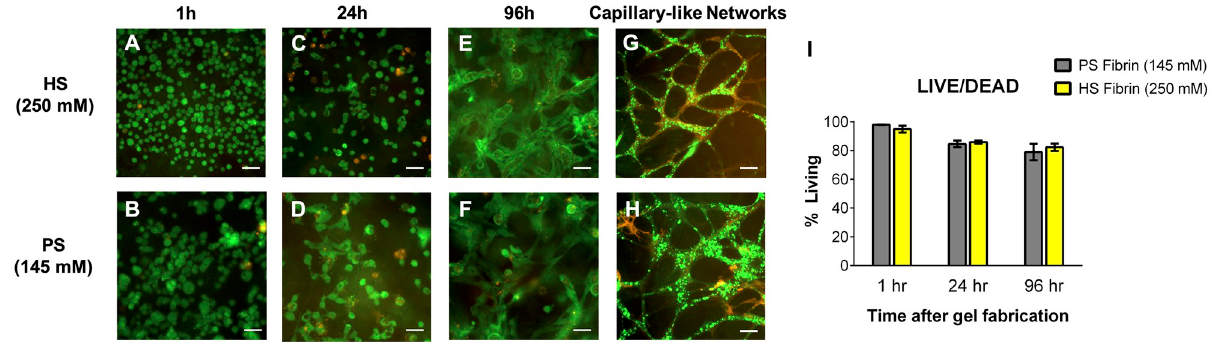
Fig 3. Increased salinity does not affect viability of encapsulated cells or ability to form endothelial networks. LIVE/DEAD 1 analysis stains Live cells green and Dead cells red. No significant difference in viability detected between amniotic fluid cells seeded in HS and PS gels (A-F), as quantified in (I). Both HS and PS gels support capillary-like network formation when seeded with GFP-HUVEC (green) and HDF (stained red with anti- α - smooth muscle actin) (G, H). Scale bars 50um.